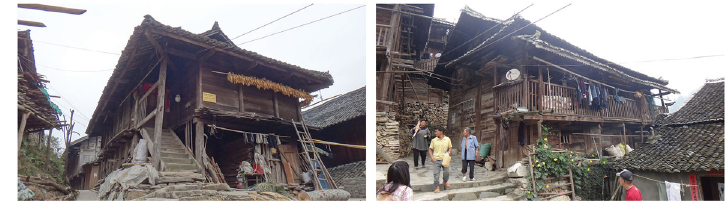
Fig. 1 General appearance of Shui houses: left, house in Zenlei Village; right, house in Bamao Village (Source: the